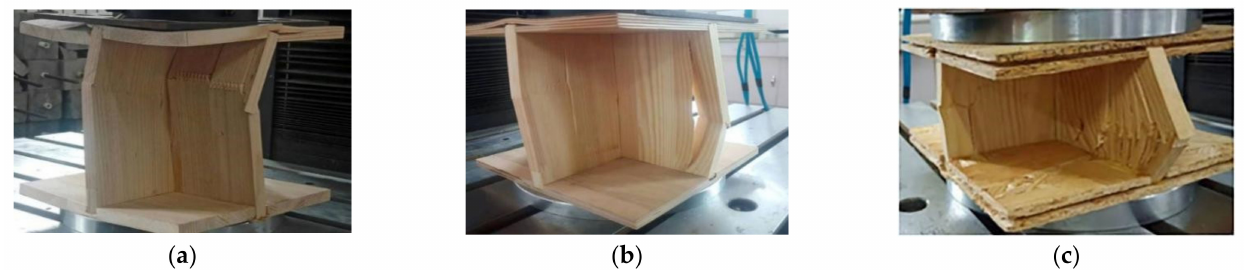
Figure 8. Failure mode of interlocking grid structure specimens. ( a ) Larch + Larch; ( b ) Plywood + Larch; ( c ) OSB +